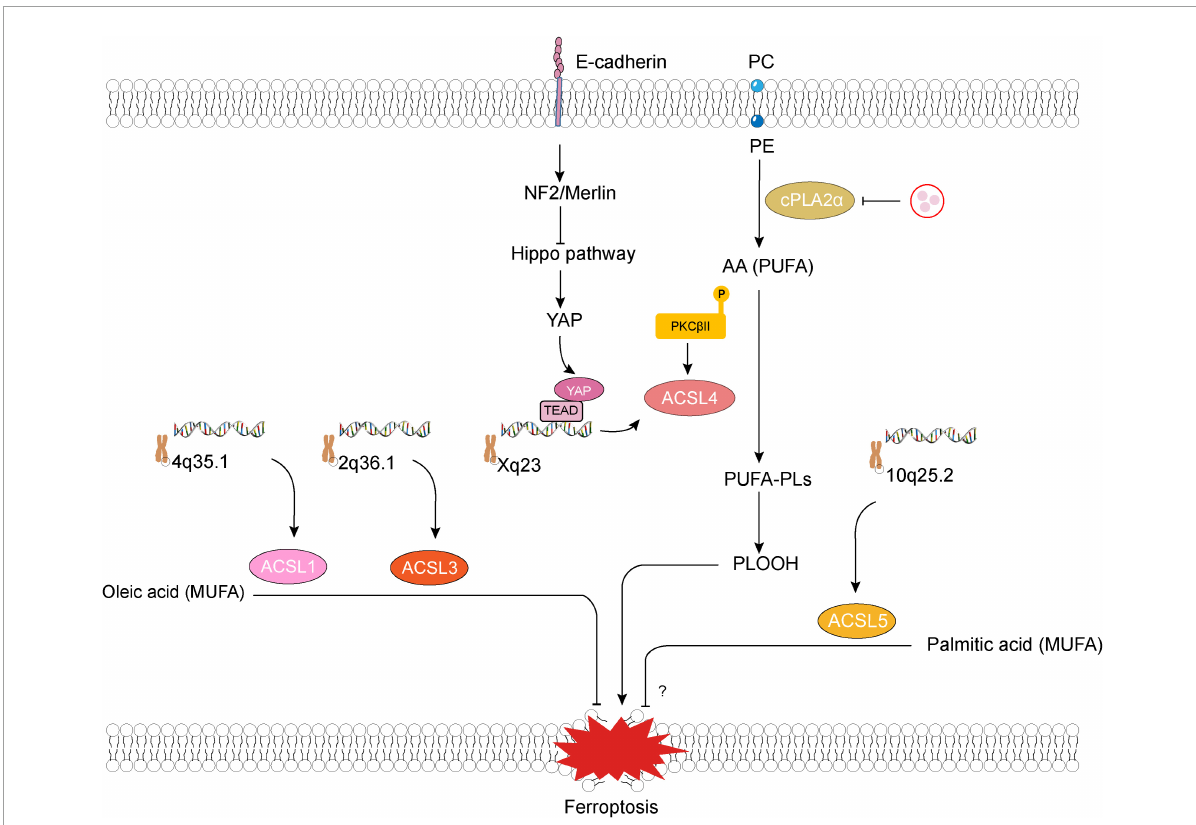
FIGURE2 Long-chain acyl-coenzyme A synthetases family member 1, 3–5 (ACSL1, 3–5) and ferroptosis. E-cadherin–NF2–Hippo–YAP pathway suppresses ferroptosis by attenuating YAP-mediated transcription and translation of ACSL4 . Lipogenesis involving production of phospholipids containing polyunsaturated fatty acid chains (PUFA-PLs) that are mediated by ACSL4 and multiple other enzymes is required for phospholipid peroxidation and ferroptosis (Jiang et al., 2021). Some pathological states (such as cerebral ischemia) would lead to an unexpected increase in thrombin within neurons, promote the mobilization of phosphatidylcholine (PC) and phosphatidylethanolamine (PE) in the phospholipid membrane of neuronal cells through cytosolic phospholipase A2alpha (cPLA2 α ), and accelerate the production of polyunsaturated fatty acid, such as arachidonic acid (AA) (Tuo et al., 2022). Besides, ferroptosis inducers promote a slight accumulation of lipid peroxide, which induces the activation of protein kinase C β II (PKC β II). Subsequently, activated PKC β II interacts directly with and phosphorylates ACSL4 at Thr328,